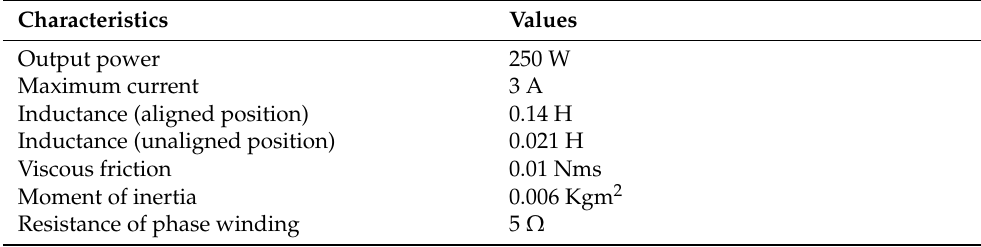
Table 2. Database of 8/6